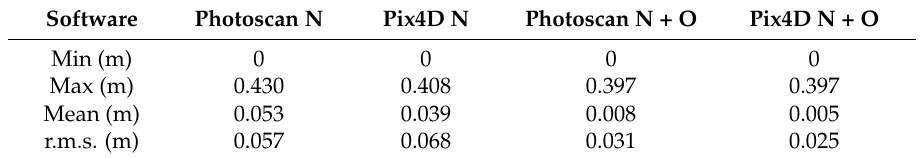
Table 13. Statistical values of the comparisons between the TLS data and the point clouds.